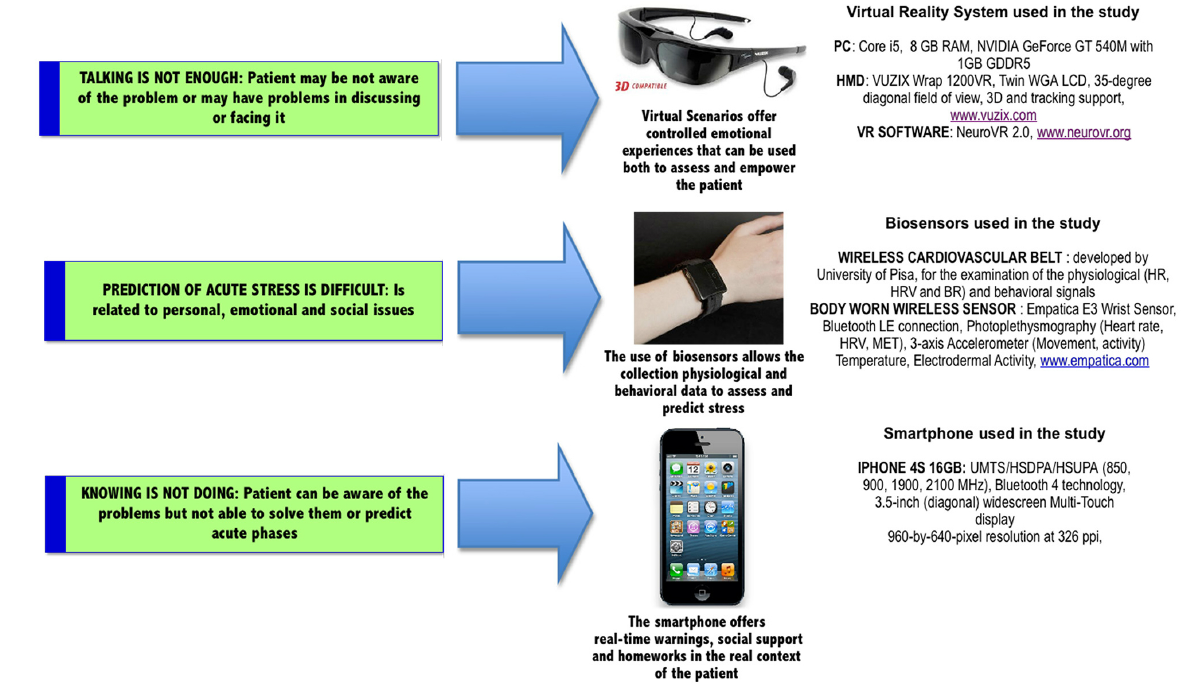
Figure 4. Technologies used by the experimental group.